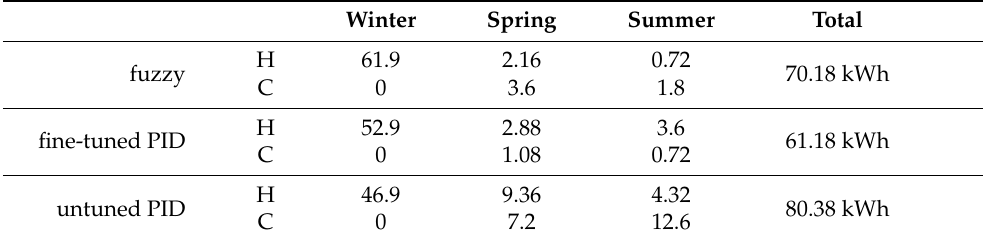
Table 1. Estimated energy consumption for simulated 3 days (H—heater 3 kW, C—cooler 1.5